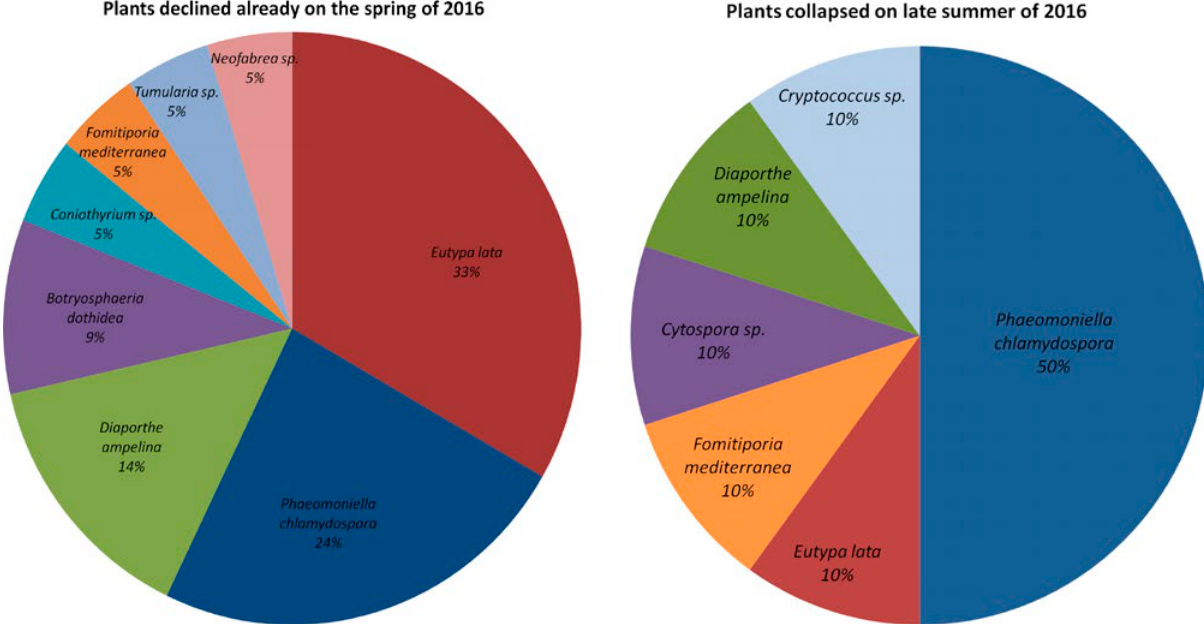
Figure 1. The proportions of fungal taxa isolated from grapevine plants showing symptoms of decline in the spring of 2016 (from seven plants, a total of 21 fungal taxa were identified; repeated occurrences of individual taxa in more plants were also counted), and grapevines that collapsed in the late summer of 2016 (in six plants, a total of ten fungal taxa were identi- fied; repeated occurrences of individual taxa in more plants were also